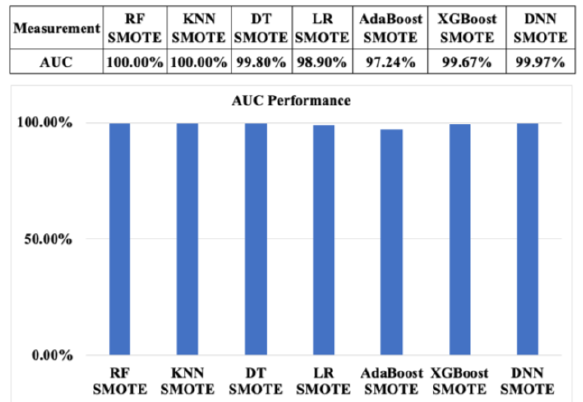
Figure 16. AUC measurement performance of machine learning algorithms with SMOTE based on resampling approach 1.